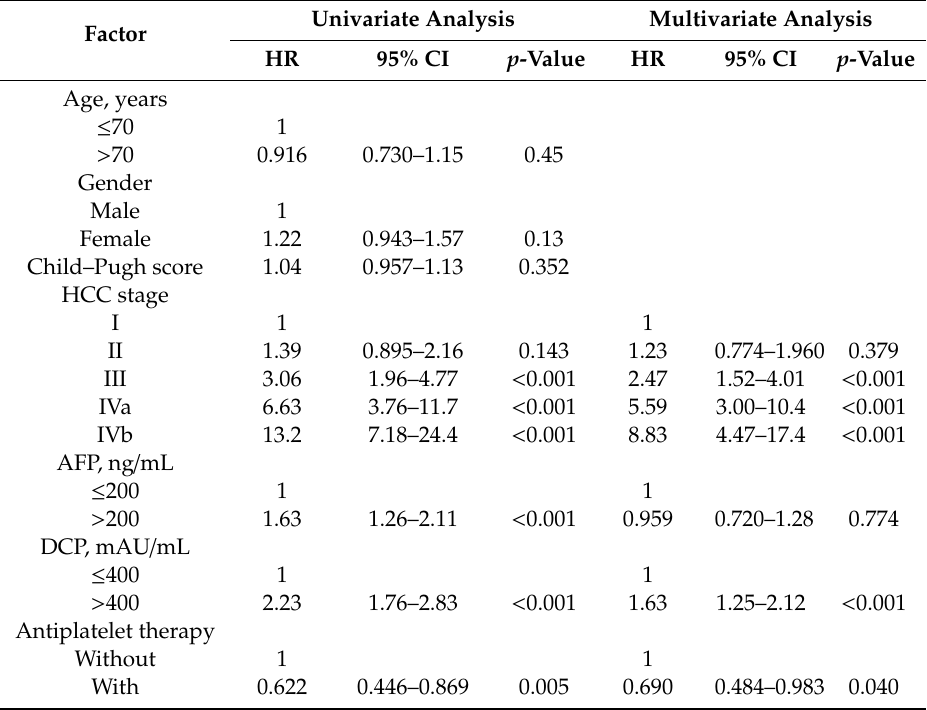
Table 3. Baseline factors associated with tumor progression in patients who underwent TACE in univariate and multivariate Cox regression